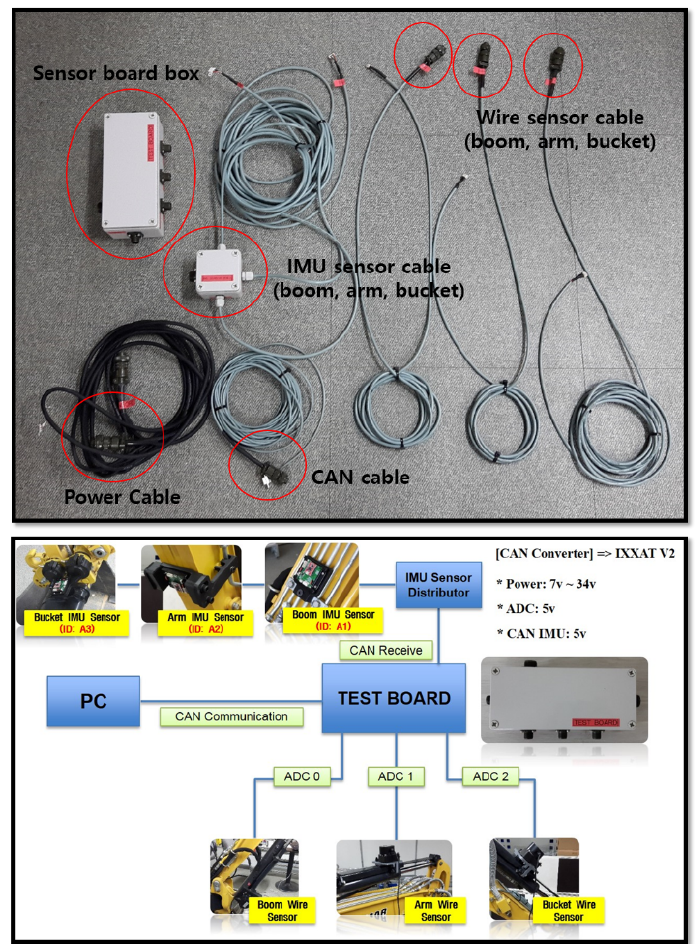
Figure 11. A schematic of the overall communication system for gathering the desired